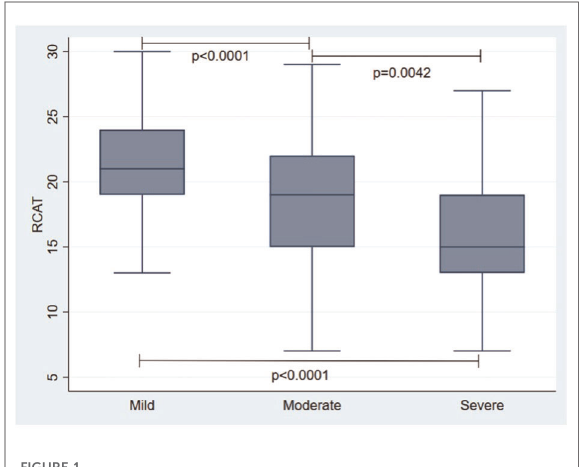
FIGURE 1 Association between rhinitis control and rhinitis